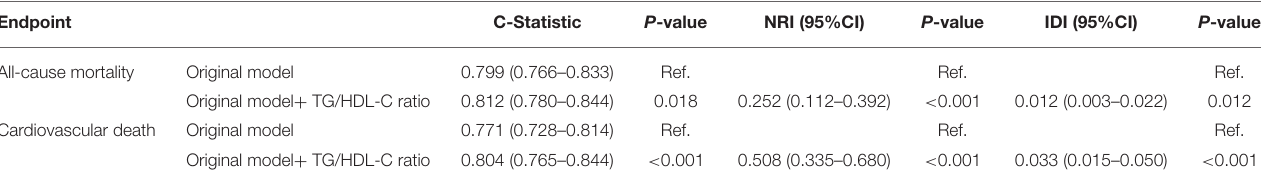
TABLE 4 | Evaluation of predictive models for all-cause mortality and cardiovascular